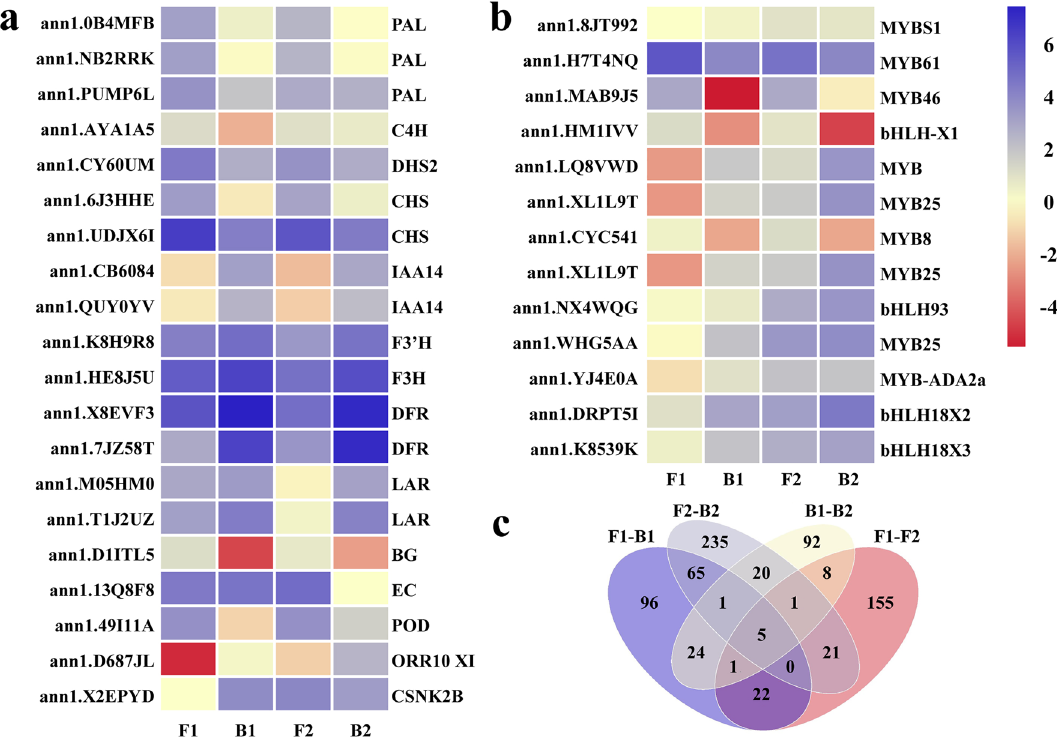
Figure 7. ( a , b ) Heat map of the DEGs related to anthocyanin synthesis in the variegated peanut testa among different comparison groups of structural genes and transcription factors. Gene expression was scaled in this analysis using FPKM (Fragments Per Kilobase of exon model per Million mapped fragments) Z-scores based on the mean value of two biological replicates in the heatmap. The key is located on the right-hand side in each case with FPKM values increasing from blue to orange. ( c ) The Venn diagram of the DEGs among different comparison